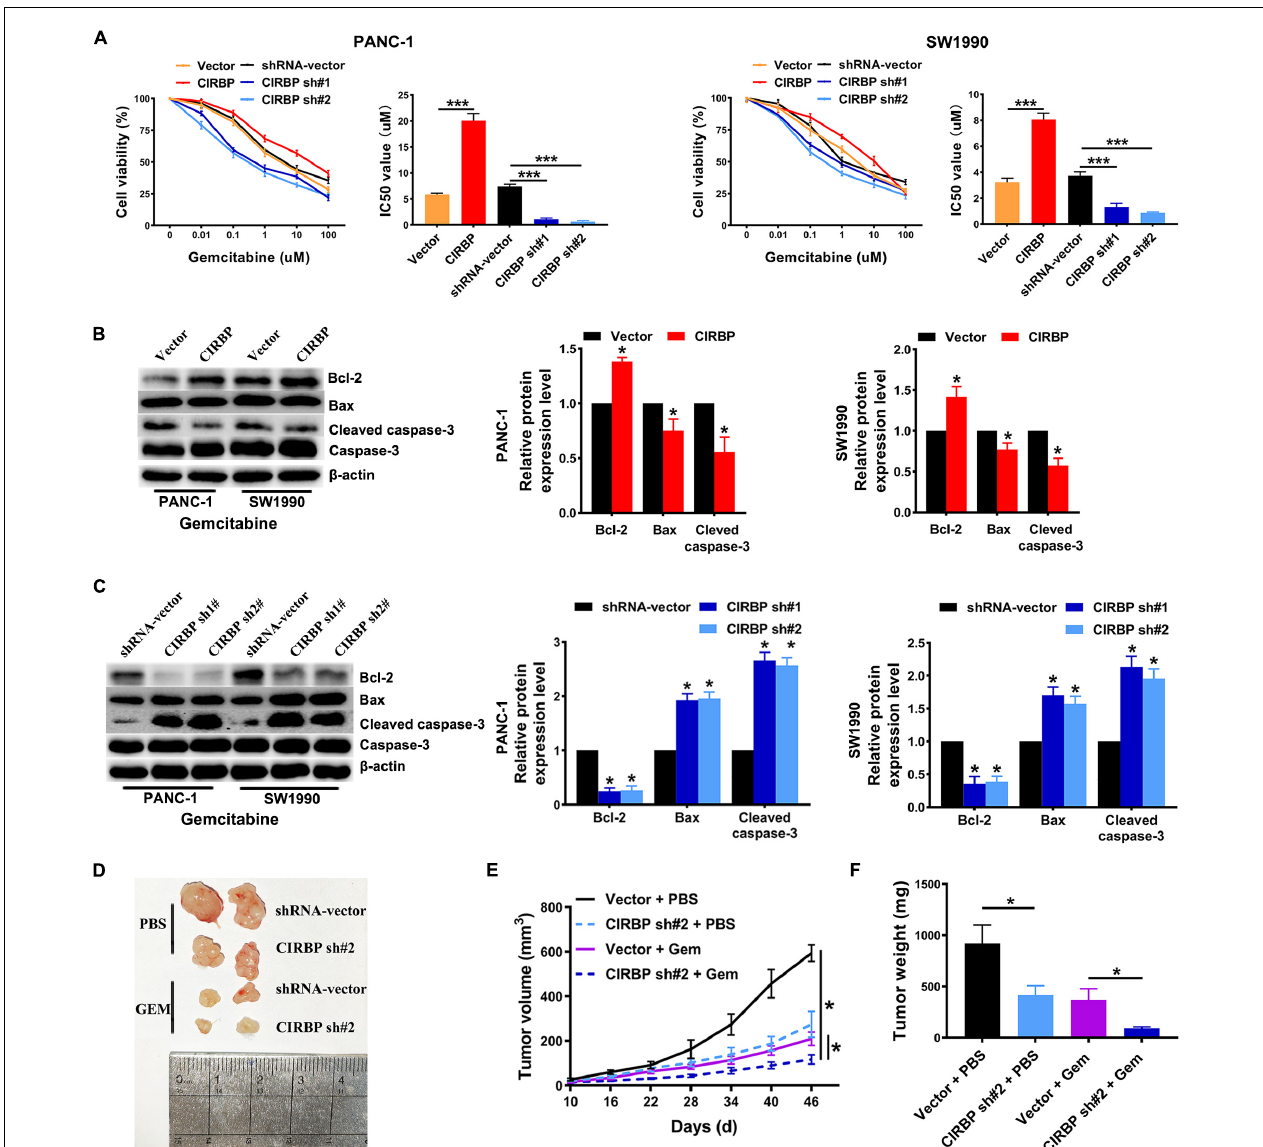
FIGURE 5 | CIRBP knockdown in pancreatic cancer cells enhances its sensitivity to Gemcitabine treatments. (A) The IC50 of gemcitabine in PANC-1 (left) and SW1990 (right) cells were determined by CCK8 assays. The mean values of the IC50 were shown. (B) Western blot analysis of bcl-2, bax and cleaved caspase-3 expression in CIRBP overexpression PDAC cells after Gemcitabine treatment for 48 h. (C) Western blot analysis of bcl-2, bax and cleaved caspase-3 expression in CIRBP knockdown PDAC cells after Gemcitabine treatment for 48 h. (D) Representative tumors with corresponding treatments. Stably transfected CIRBP shRNA #2 or shRNA-vector PDAC cells were injected in nude mice, which were then divided into vector + PBS, CIRBP sh#2 + PBS, vector + Gem and CIRBP sh#2 + Gem groups and treated as described in the Section “Materials and Methods” ( n = 5 per group). (E) Tumor growth curves. The sizes of tumors were measured every 6 days after tumor cell inoculation. * P < 0.05, repeated measures analyses of variance with Bonferroni correction. (F) Tumor weight of each group was measured at the end of the experiment. Data are presented as means ± SD. * P < 0.05, *** P < 0.001, unpaired student’s t